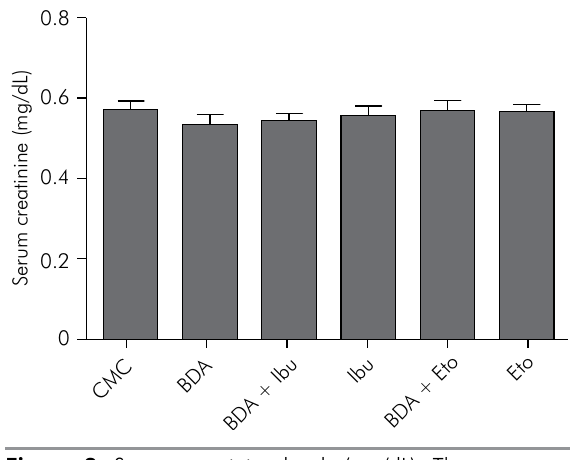
Figure 2. Serum creatinine levels (mg/dL). There were no statistically significant differences between groups (p >